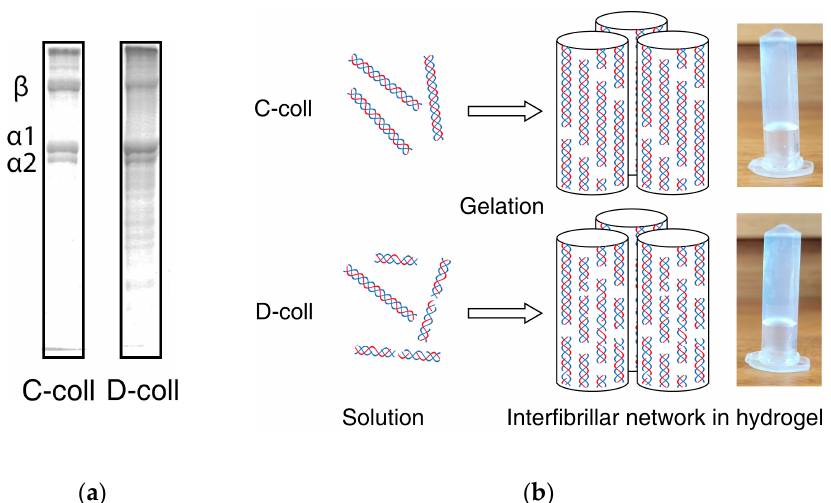
Figure 1. ( a ) Intact collagen (C-coll) and hydrolyzed collagen solution (D-coll) used for forming hydrogel and the corresponding sodium dodecyl sulfate–polyacrylamide gel electrophoresis (SDS–PAGE) results using 7% acrylamide gel highlighting collagen α chains and β chains, and ( b ) the schematic shows that collagen molecules assemble into the fibrillar network in the hydrogels.